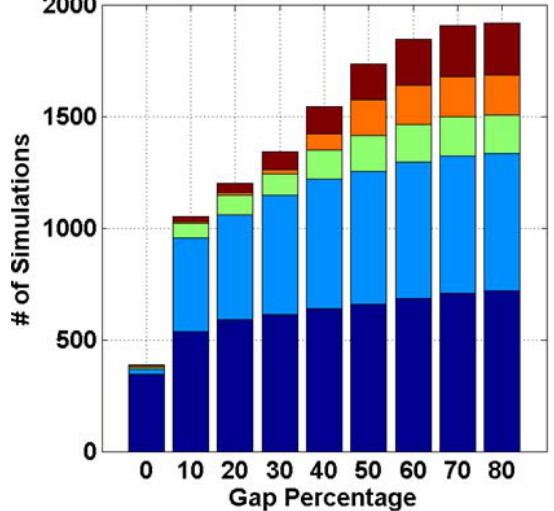
Fig. 4. Cumulated distribution of the fraction of missing data (%gap) in the simulated time series (LAI sim ) for each of the 5 veg- etation classes (SB, CG, DB, EB,